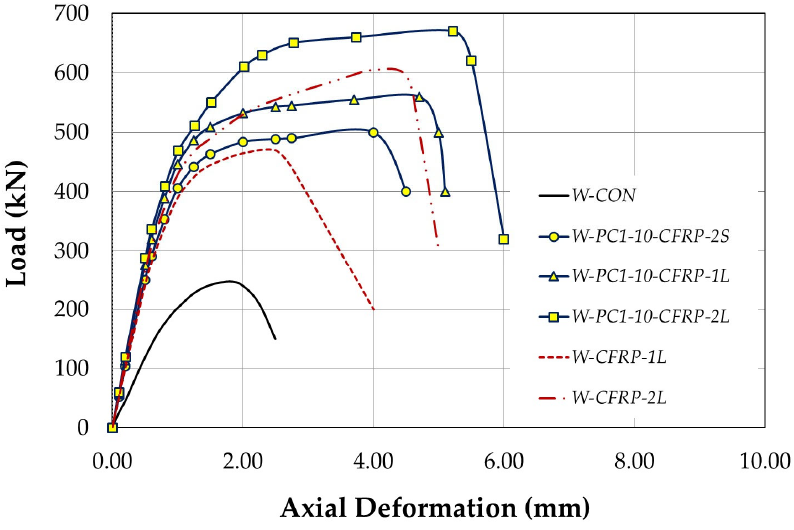
Figure 9. Axial Load versus axial deflection responses of all CCI brick masonry walls.